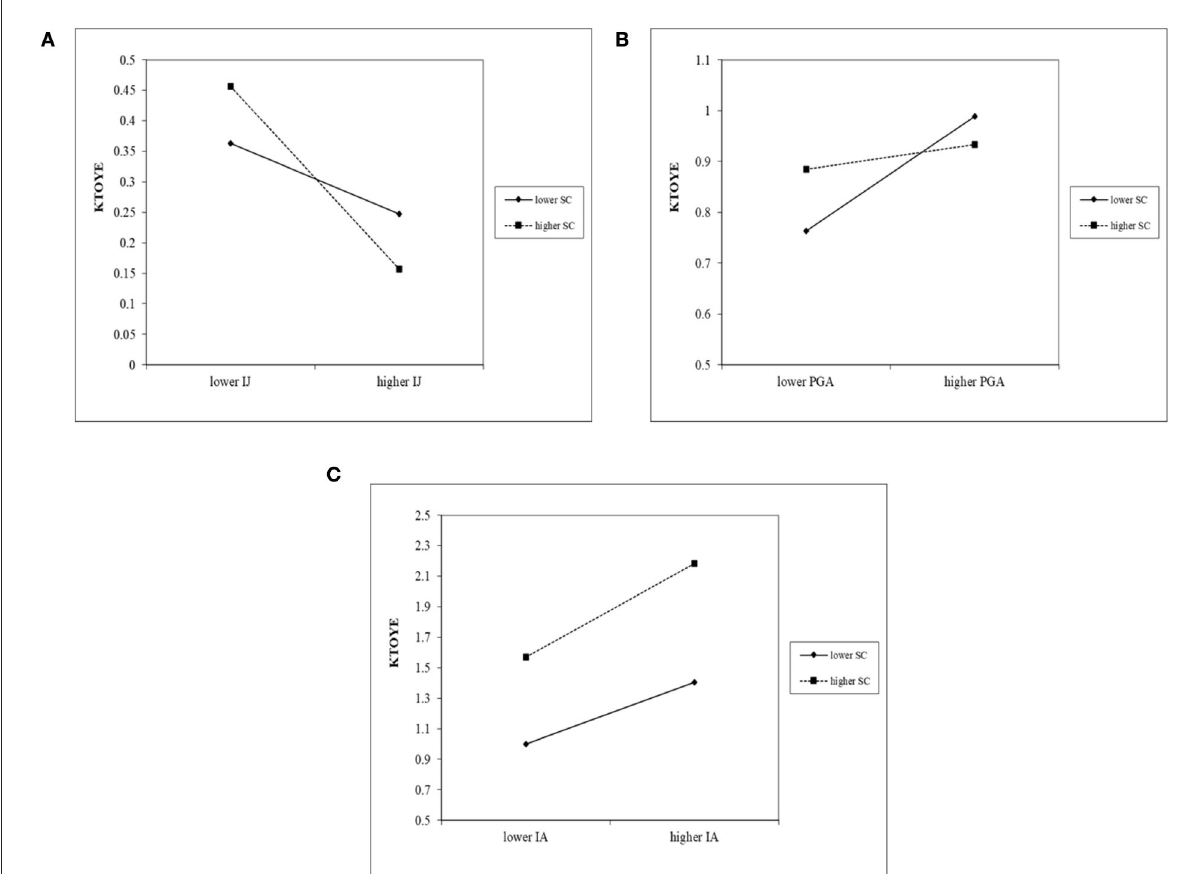
FIGURE2 Plots of moderating effects. (A) Moderating effect of SC on the relationship between IJ and KTOYE; (B) Moderating effect of SC on the relationship between PGA and KTOYE; (C) Moderating effect of SC on the relationship between IA and KTOYE; IJ, interactional justice; PGA, perceived goal attainment; IA, interactional association; SC, supportive climate; KTOYE, knowledge transfer from older to younger